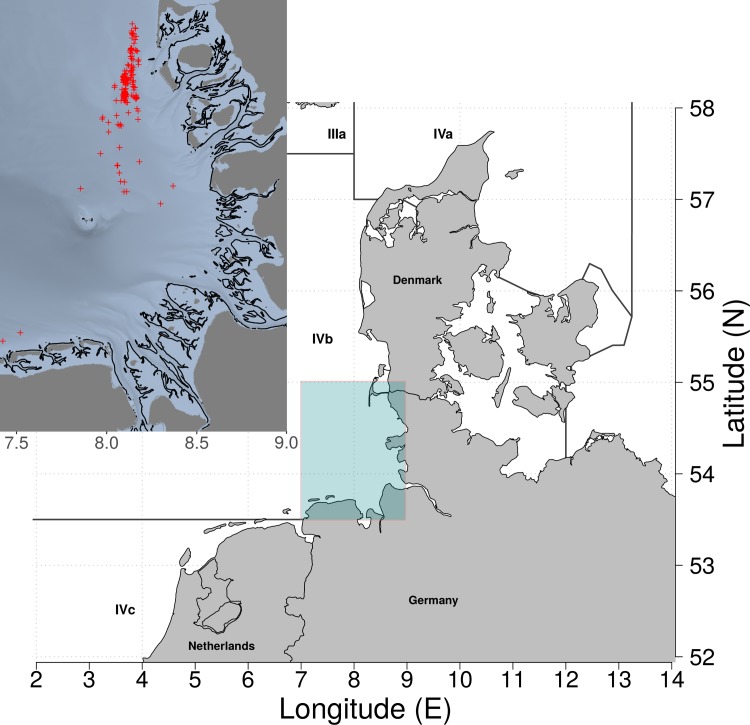
Location of the experimental hauls conducted during the four different cruises.